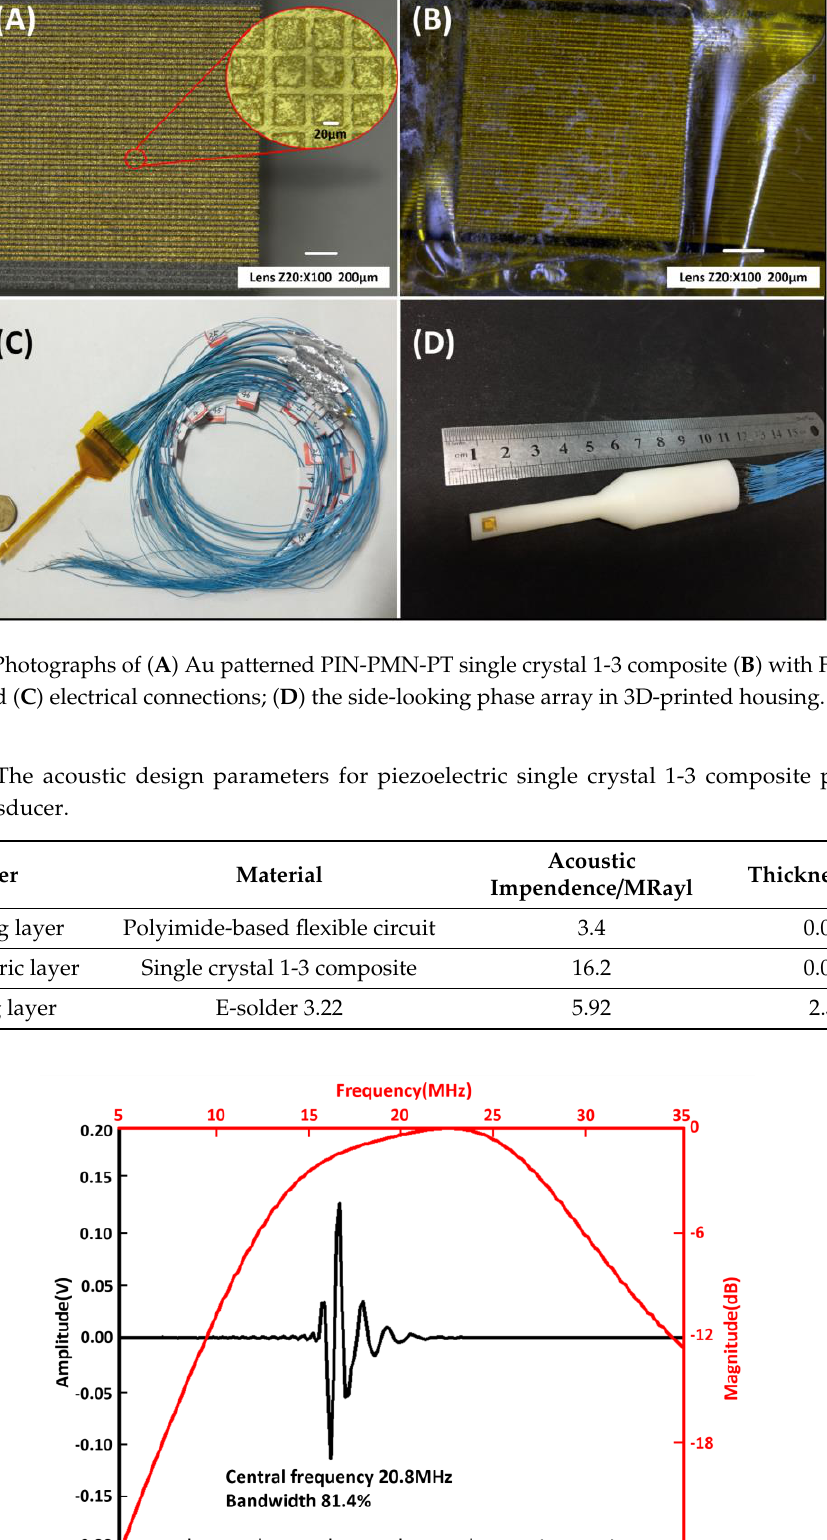
Figure 2. Photographs of ( A ) Au patterned PIN-PMN-PT single crystal 1-3 composite ( B ) with